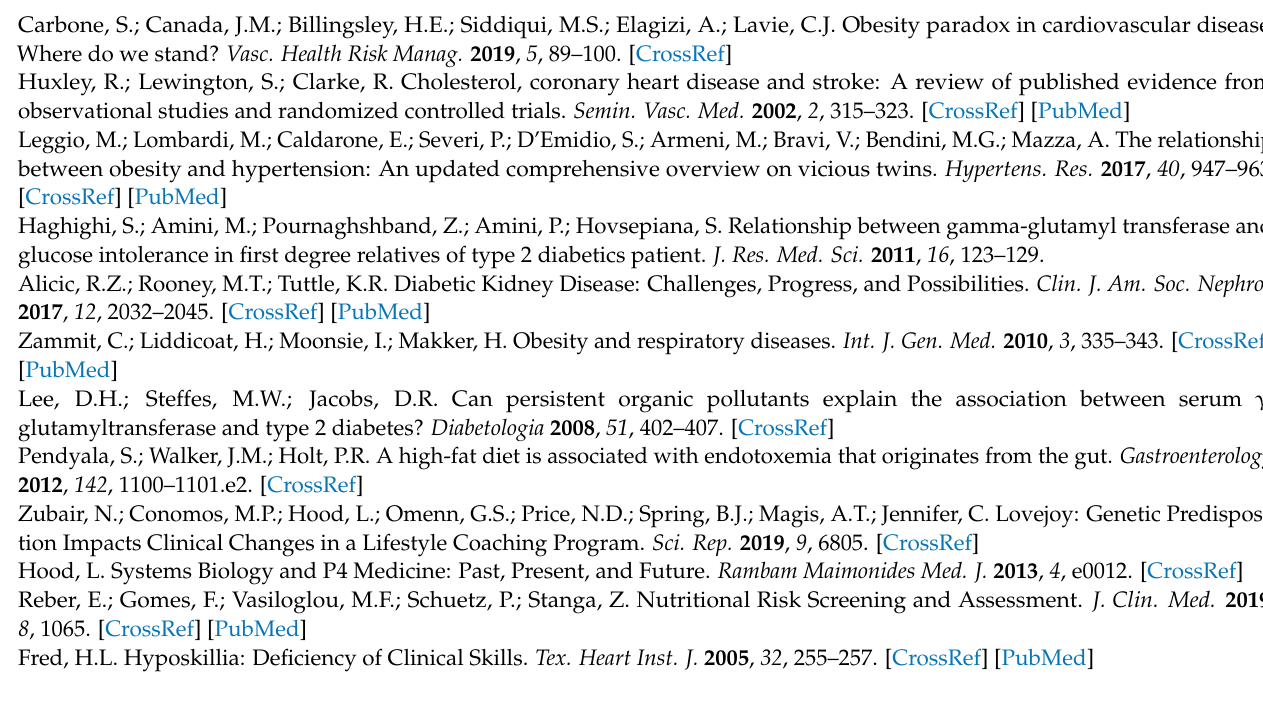
and Occupation. Table S2: Physical Exam Findings for Hair, Skin, and Nails Comparison by Sex, Age, and Occupation. Table S3: Physical Exam Findings for Mouth, Tongue, Teeth, Comparison by Sex, Age, and Occupation. Table S4: Physical Exam finding for Smell, Taste and Sensory Neurological Exam Comparison by Sex, Age, and